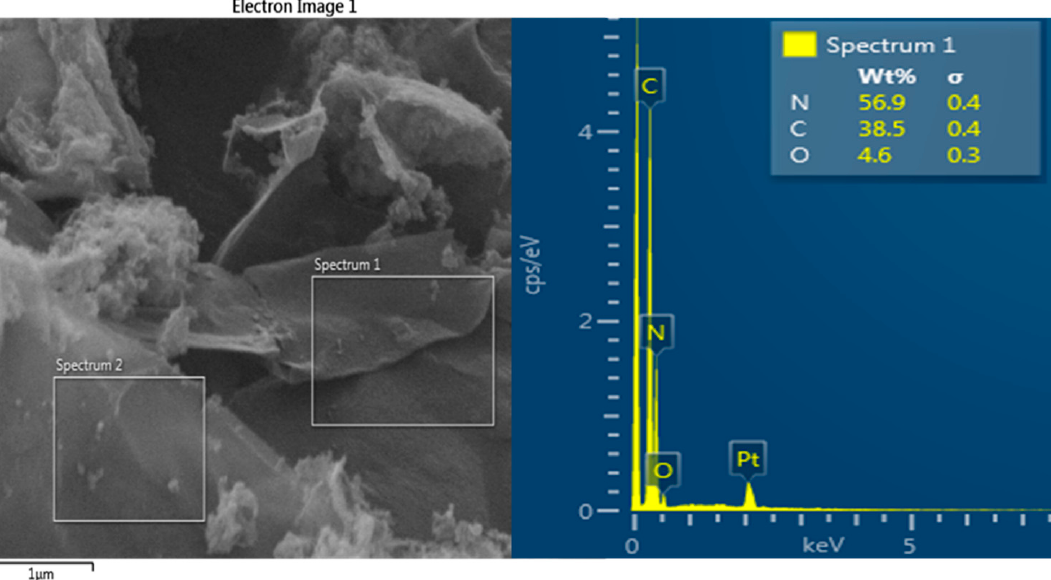
Figure 3. The element’s presence in the Gr/g-C 3 N 4 sample.